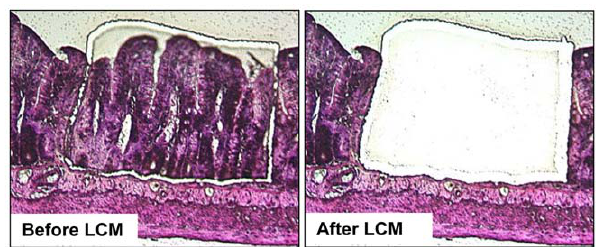
Figure 1. Images of HE stained jejunum sections (20 6 ) before and after Laser Capture